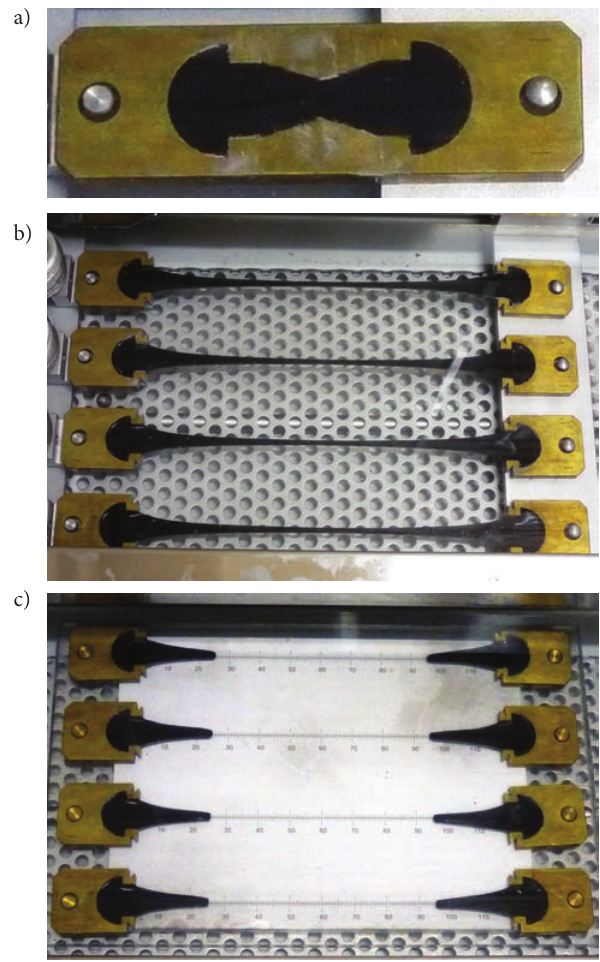
Fig. 1. Stages of procedure for determining the strain recovery: a – sample prepared for testing conditioned in a water bath at a fixed test temperature; b – samples stretched at a constant speed of 50 mm/min until the elongation of 200 mm; maintaining a constant strain in order to achieve the effect of relaxation; c – measuring the strain recovery at specified time intervals